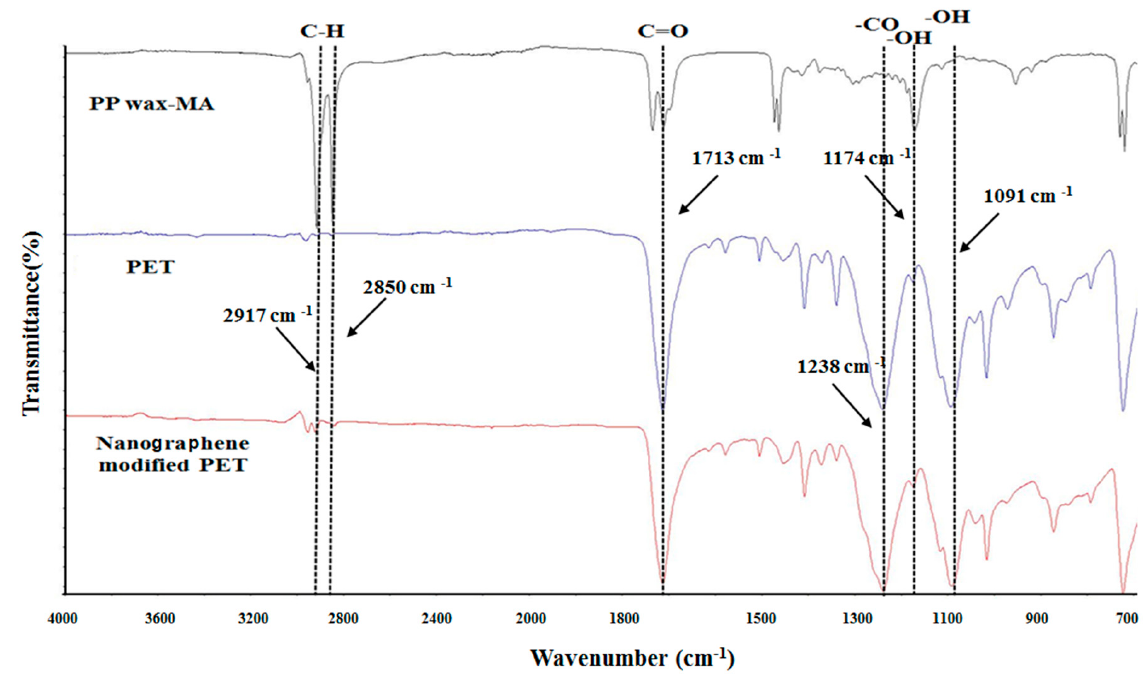
Figure 7. FTIR analysis result of various polymers.